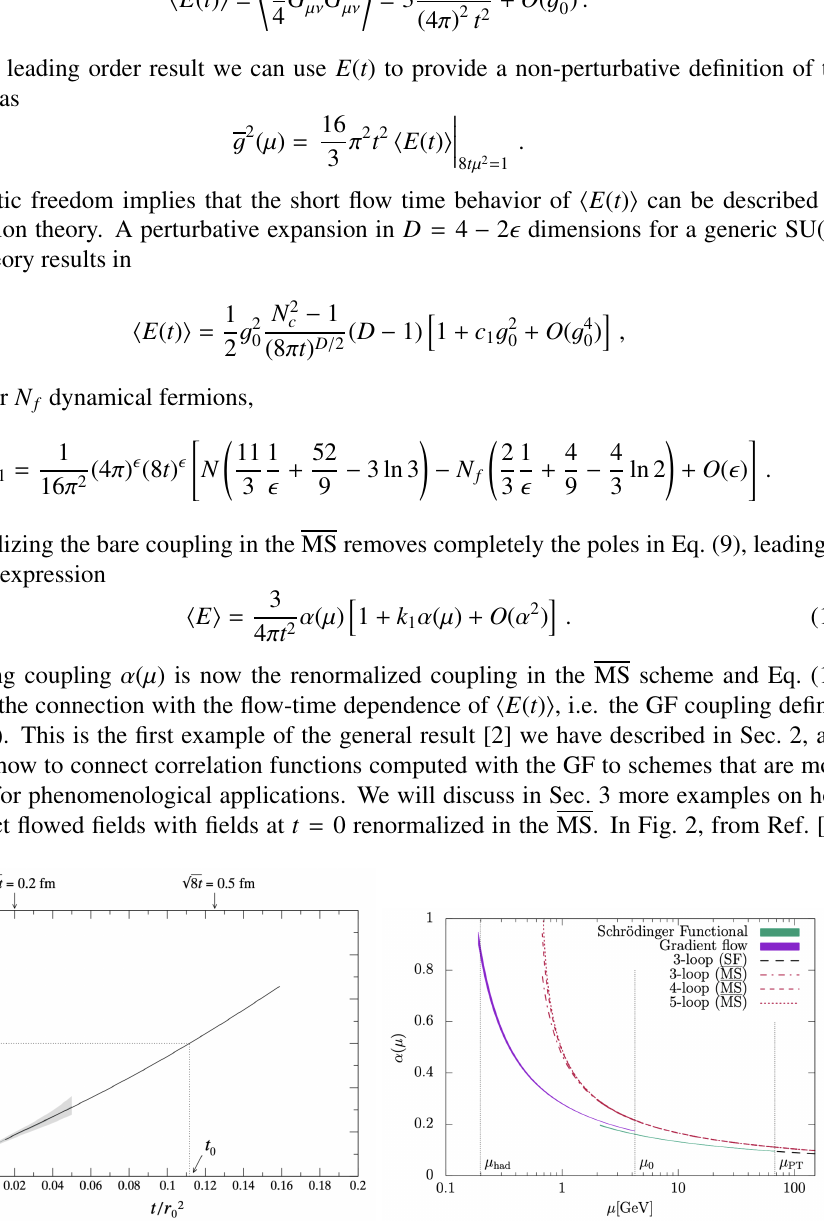
(cid:68) (cid:69) G µν G µν in the quenched model. The